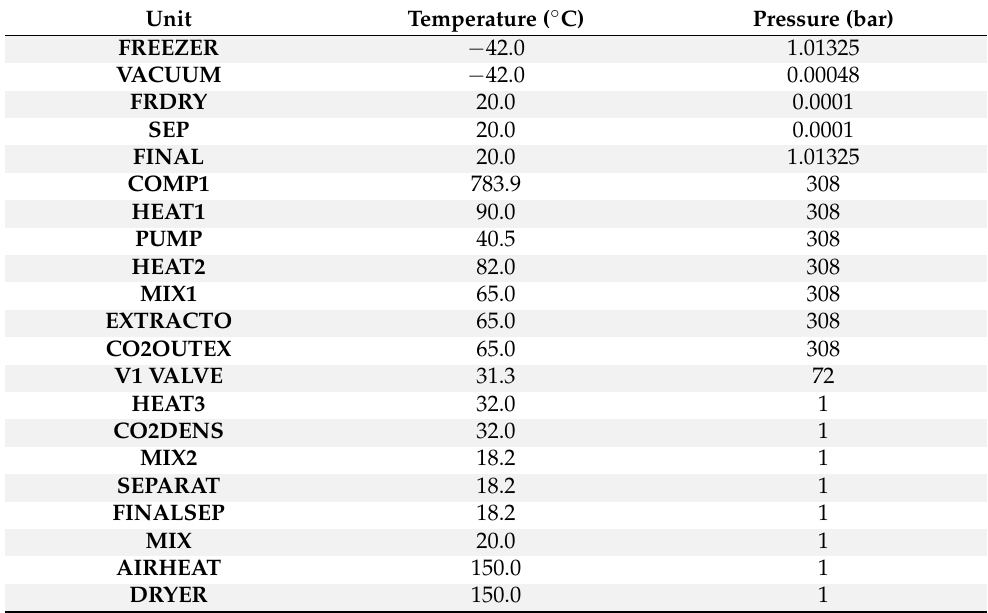
Table 1. Temperature and pressure of each unit block used in the simulation model. Unit Temperature ( ◦